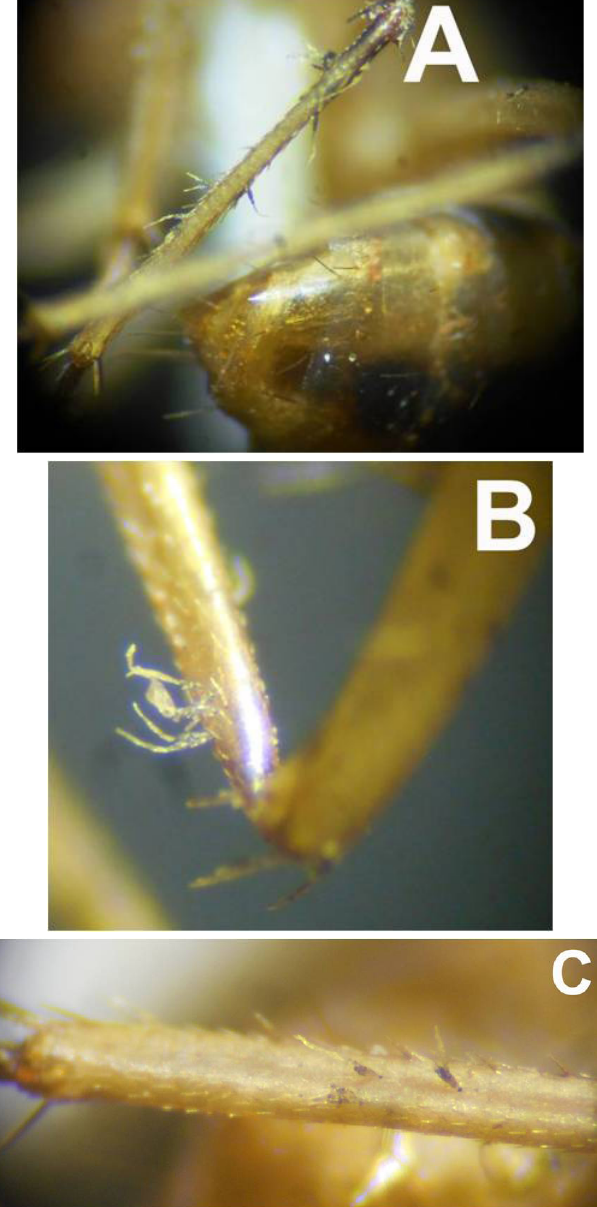
Fig 2 . Different views of Laboulbenia.camponoti Batra on the legs of Camponotus oasium Forel. SENEGAL: Kaolack, road between Birkelane and Kaffrine. Mature thalli show a darkened body; immature thalli are still hyaline and have an uninflated perithecium. A) Mature, blackish thalli on the third leg tibia. B) Immature specimens at the proximal end of second tibia. C) One fully mature and one nearly mature thallus on the third